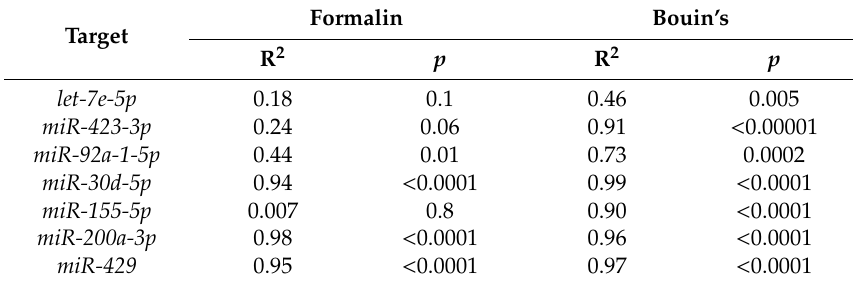
Table 5. Results on RT-qPCR data normalization in paired formalin- and Bouin’s-fixed tissues.